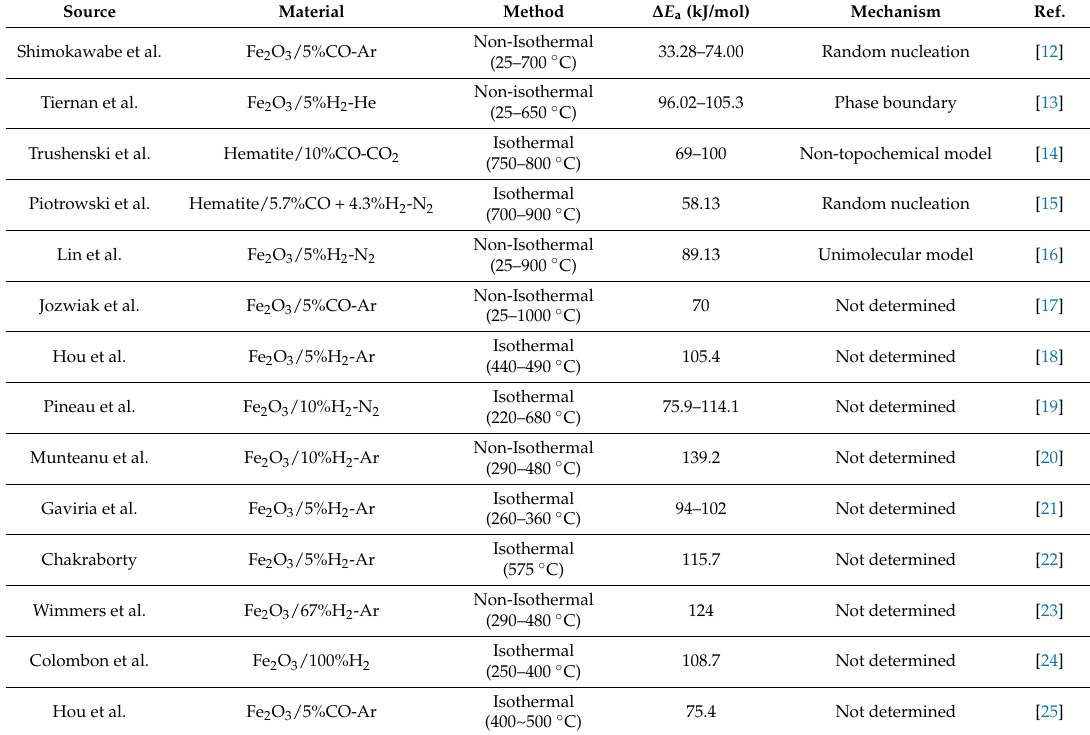
Table 1. Summary of the activation energy values and reduction mechanisms reported in the